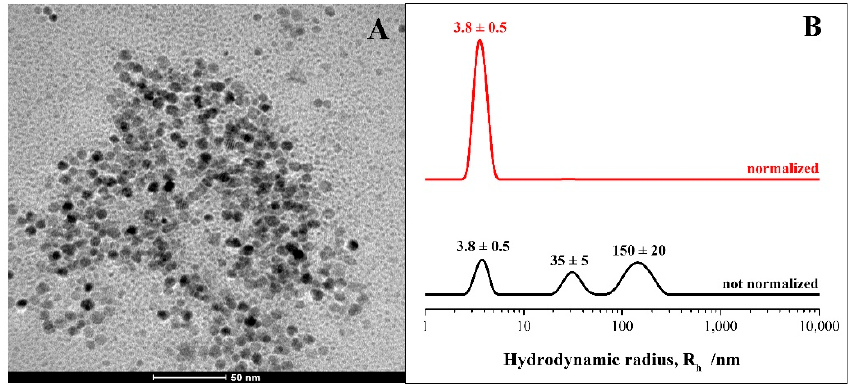
Figure 13. Panel ( A ) TEM micrographs (scale bar: 50 nm) and panel ( B ) hydrodynamic radius distributions of the AgNPs produced by SAMU.